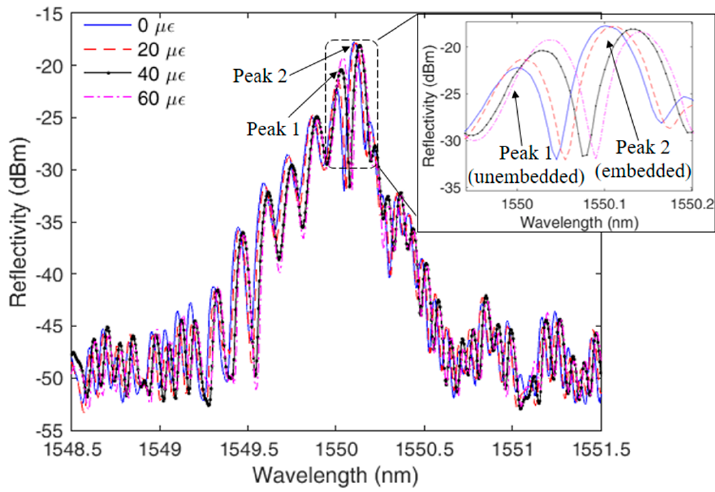
Figure 3. Half-embedded FBG spectra at different strains. Inset shows the magnified view of the two peaks created on the FBG embedment.